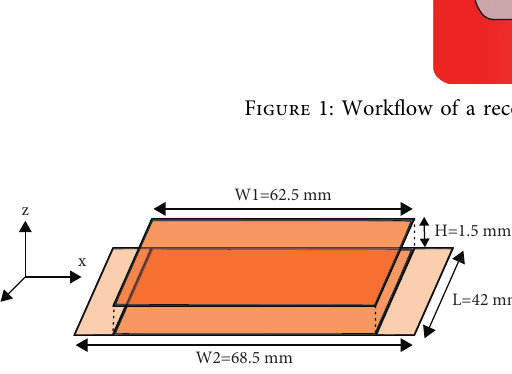
Figure 2: Geometry of the structure considered for the CMA.